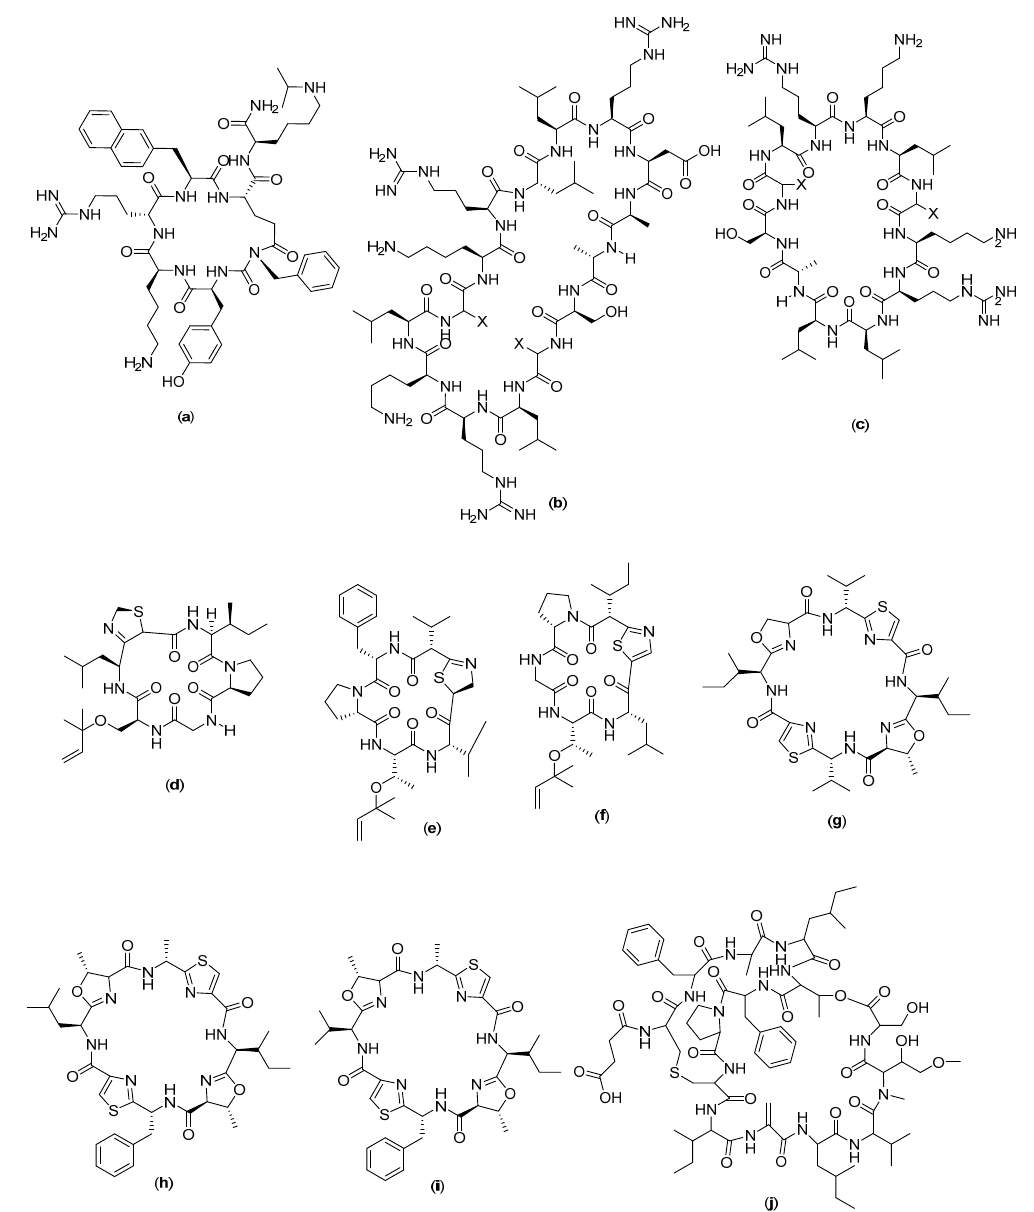
Figure 9. Structure of ( a ) LYS2510924 ( b ) MCOG 1; ( c ) MCOG 2; ( d ) Keenamide; ( e ) Mollamide A; ( f ) Mollamide B; ( g ) Patellamide A; ( h ) Patellamide B; ( i ) Patellamide C; and ( j ) Vitilevuamide.